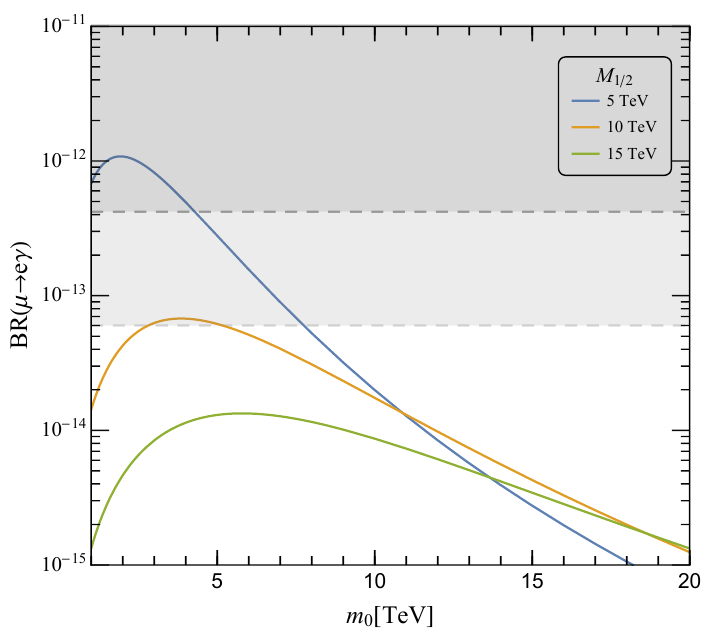
Figure 3 . The prediction for BR( µ → eγ ) versus m 0 with F τ = m 0 / 4 in the minimal model for = 5 , 10 , 15 TeV respectively. The dark grey region is excluded by the current experimental M 1 / 2 bound BR( µ → eγ ) < 4 . 2 × 10 − 13 [115]. The light grey dashed line denotes the future